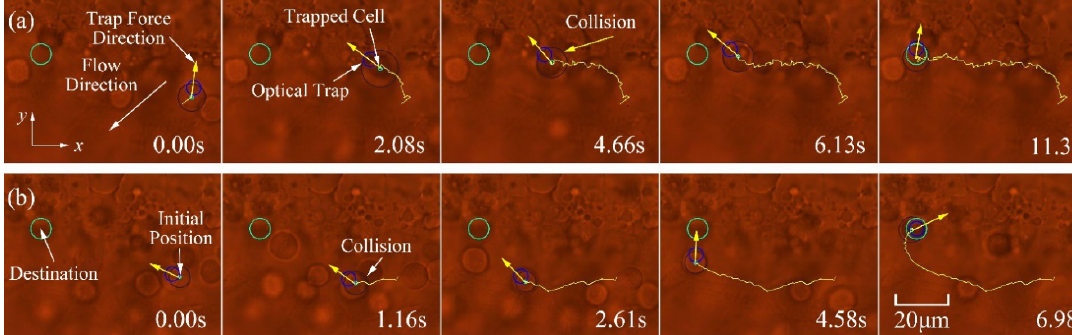
Figure 4. Snapshots of in vivo red blood cells (RBCs) transportation in a living zebrafish; ( a ) disturbance compensation controller; and ( b ) P-type controller. Reproduced with permission from [37].